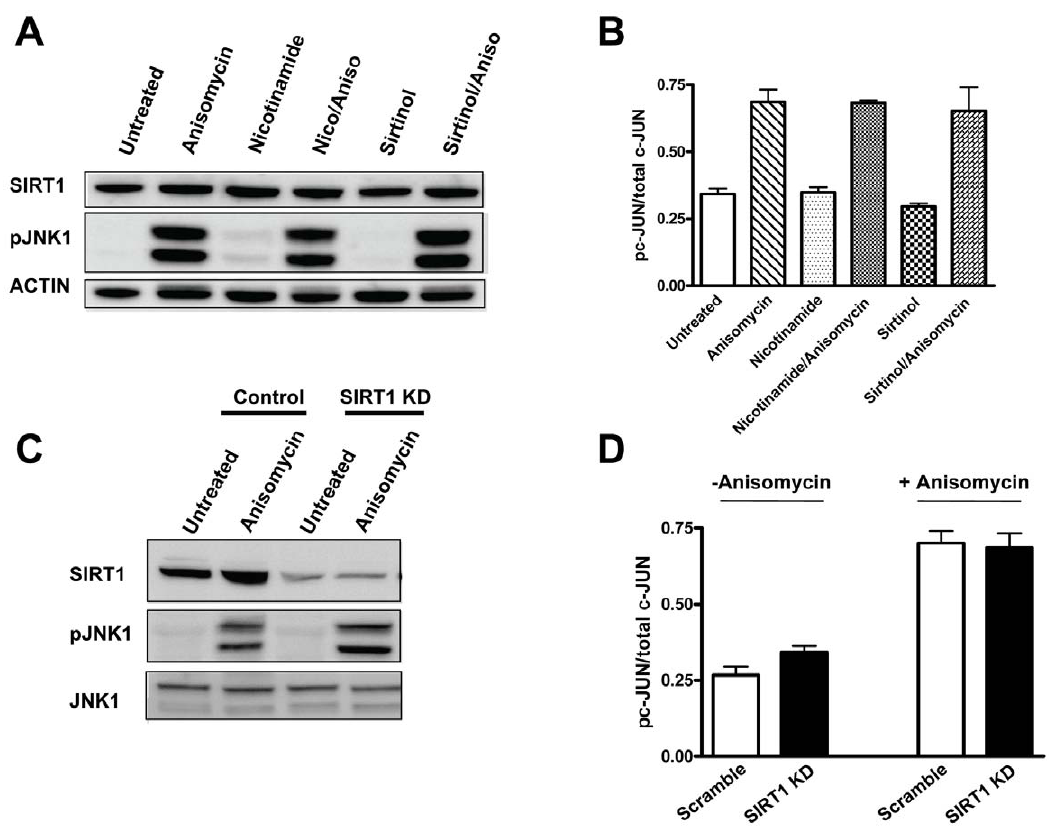
Figure 3. SIRT1 does not regulate JNK1 phosphorylation or activity. A , Inhibition of SIRT1 activity by nicotinamide or Sirtinol does not affect phosphorylation of JNK1 in response to anisomycin. B , Inhibition of SIRT1 activity by nicotinamide or Sirtinol does not affect activity of JNK1 in response to anisomycin. JNK1 activity was measured by its ability to phosphorylate c-Jun. C , Knockdown of SIRT1 by siRNA does not affect anisomycin-mediated phosphorylation of JNK1. D , Knockdown of SIRT1 does not affect anisomycin-stimulated activity of JNK1. Clear bars are control. Black bars are SIRT1 knockdown.